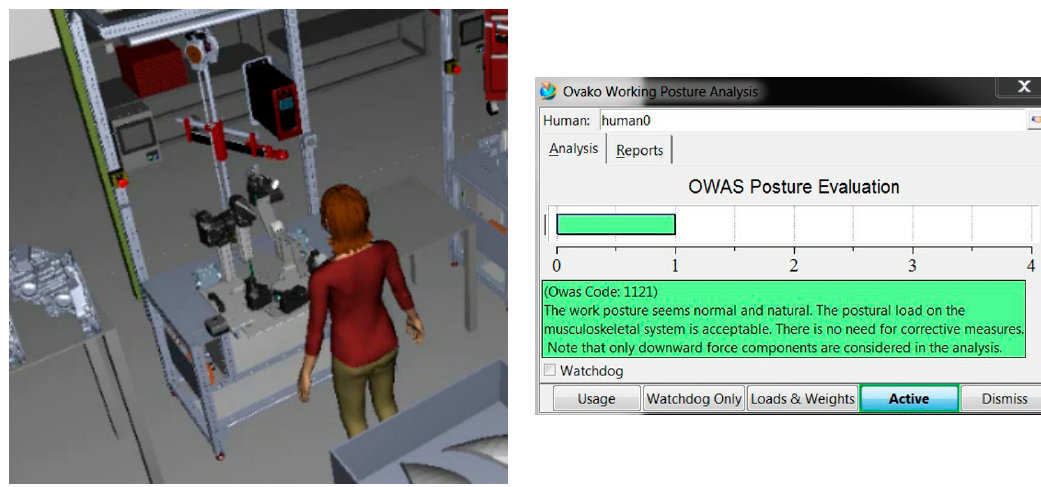
Figure 6. Computer based workplace simulation with Ovaco working analyzing system (OWAS)